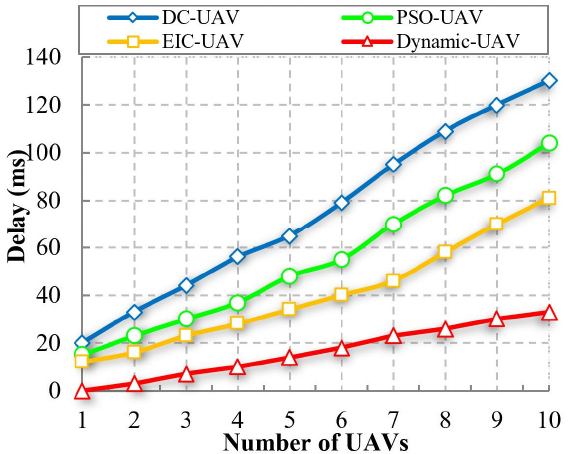
Figure 11. Delay vs. Number of UAVs.